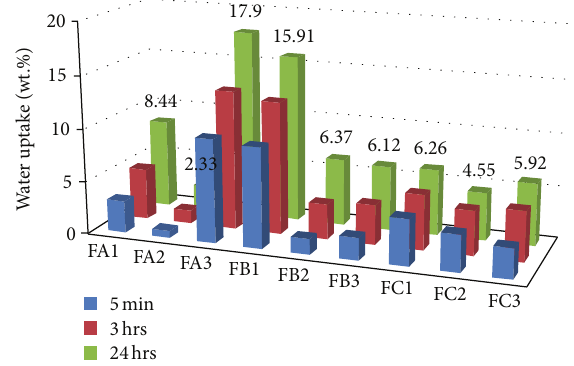
Figure 2: Water uptake of polyurethane